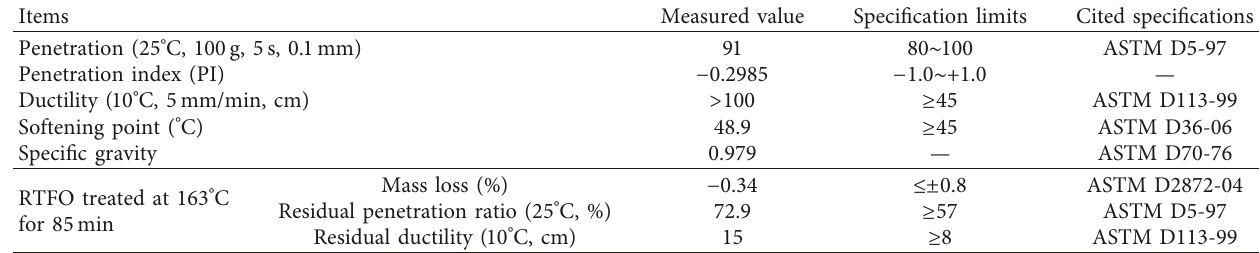
Table 1: Technical indexes of SK90# raw